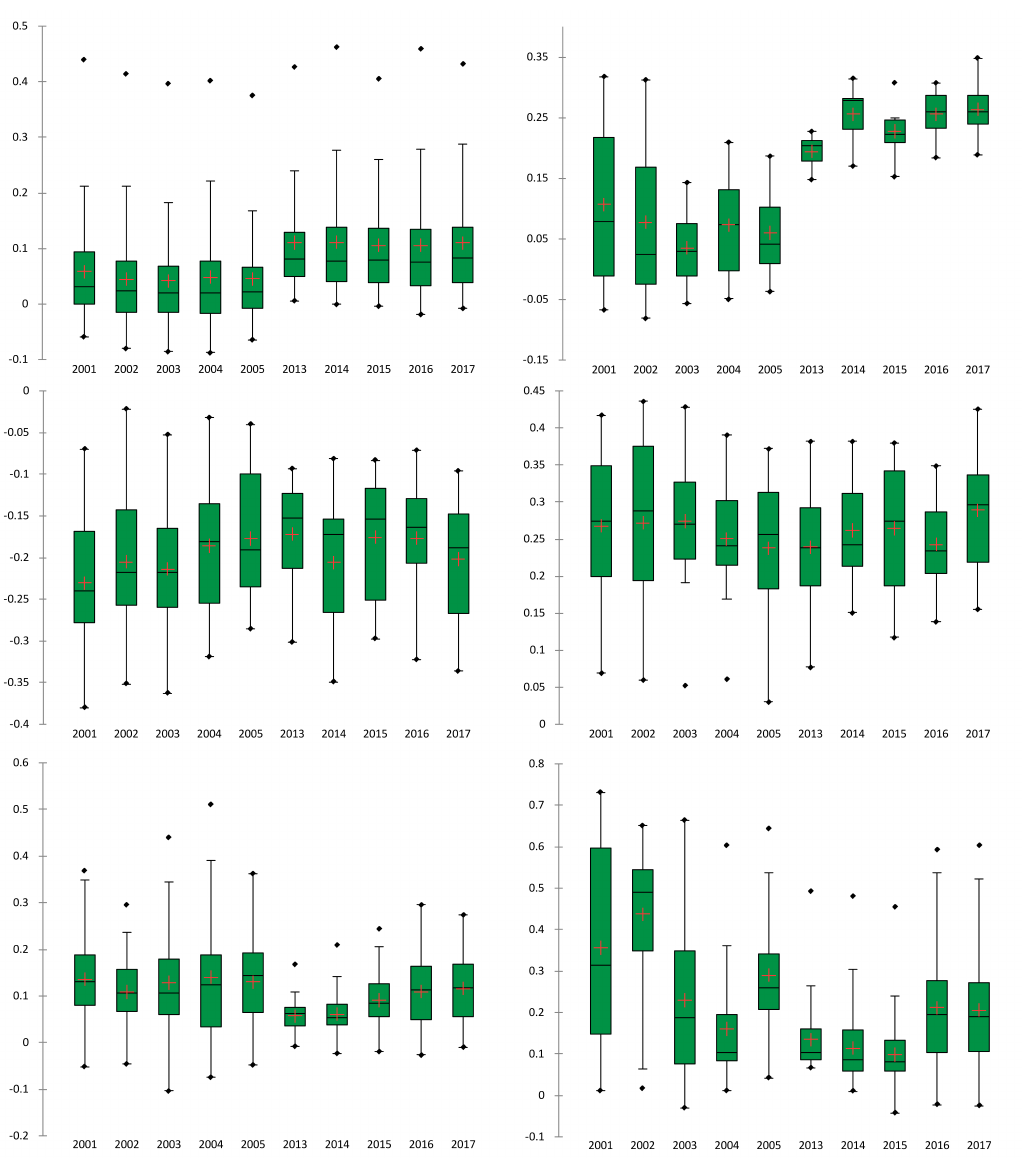
Figure 10. NDVI boxplots for the six sites: Confluence ( top-left ), Kaplan Park ( top-right ), dock ( middle-left ), Garibadi Street ( middle-right ), Museum ( bottom-left ), and Groupama Stadium ( bottom-right ); red cross: average; black dots: min and max